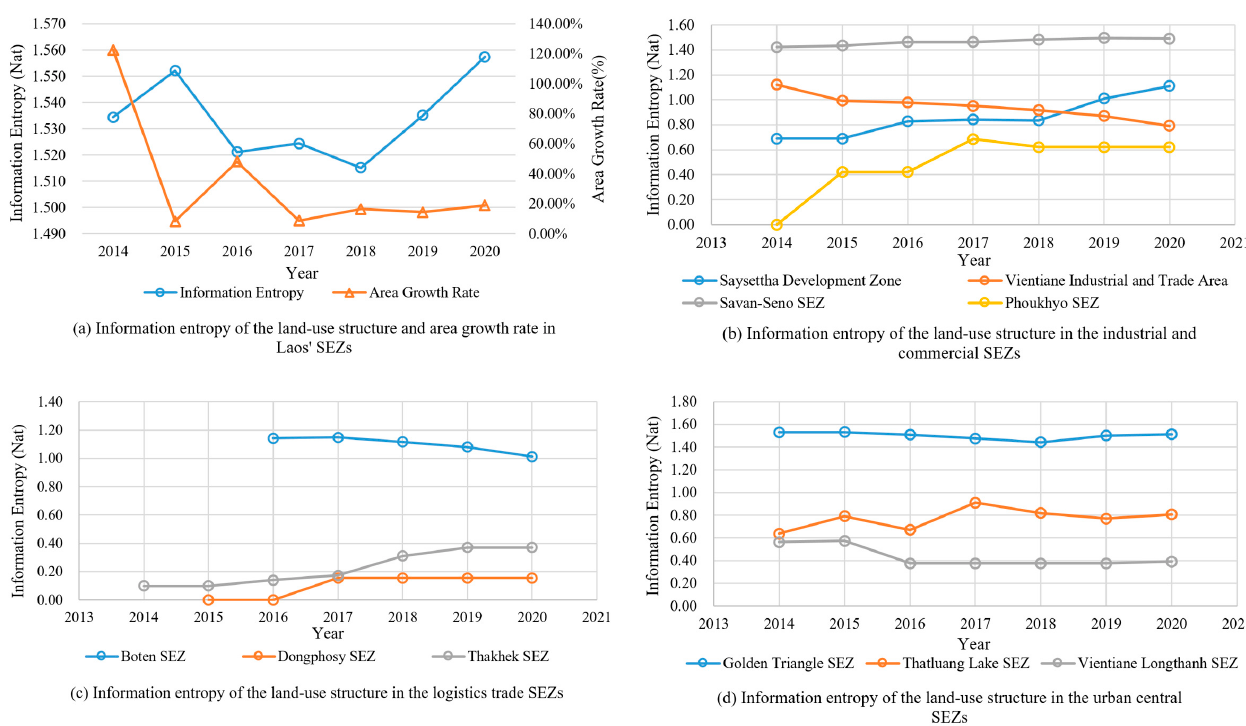
Figure 6. Annual change in the information entropy of the land-use structure in Laos’ SEZs from 2014 to 2020. ( a ) Information entropy of the land-use structure and area growth rate in Laos’ SEZs, ( b ) information entropy of the land-use structure in the industrial and commercial SEZs, ( c ) information entropy of the land-use structure in the logistics trade SEZs, and ( d ) information entropy of the land-use structure in the urban central SEZs.